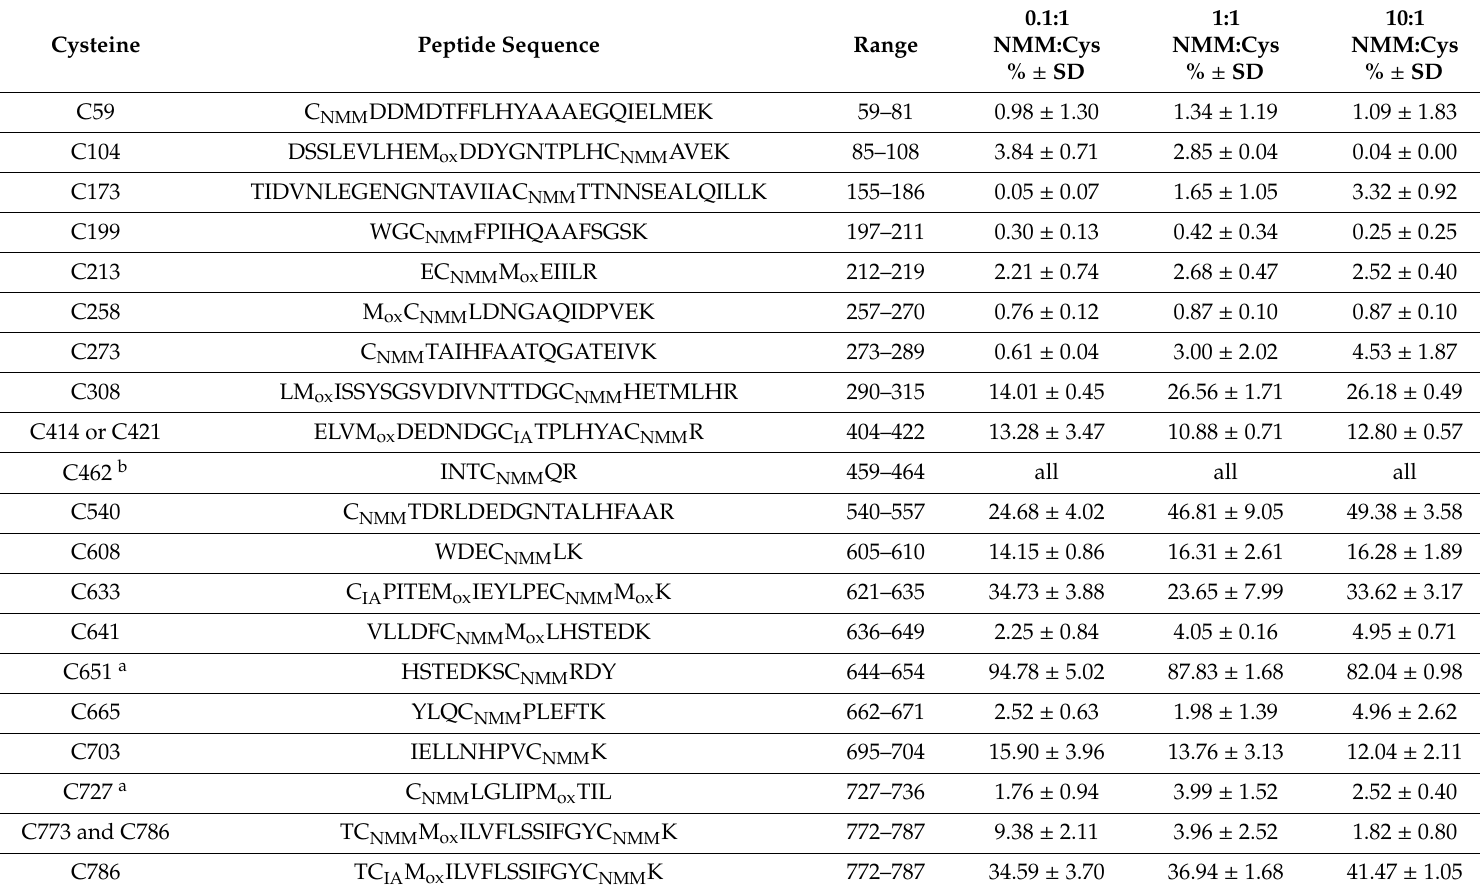
Table 1. The percentage of N -methylmaleimide (NMM) labeling for each cysteine in the human TRPA1 was analyzed from tryptic digested peptides. The NMM labeling was calculated for each cysteine by area of NMM modified peptide divided with total areas of NMM modified peptide and equivalent iodoacetamide (IA) modified peptide. The mass spectrometry experiments were performed in triplicates for each concentration, and the quantified data presented as the mean value with standard deviation (SD). The proteins were incubated at di ff erent concentrations of NMM, corresponding to di ff erent molar ratios relative the total number of